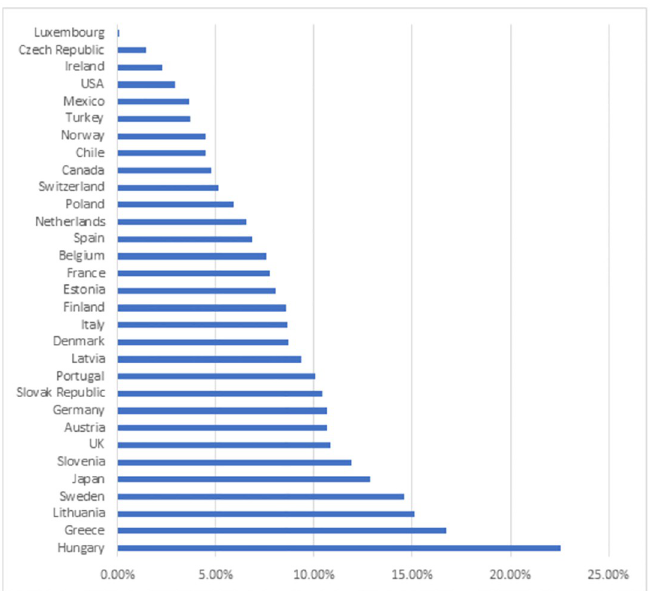
Fig 2. Rating of countries on the stability of financial development in 2020. Source: authors’ calculations based on the official statistical data [50]. index; and Hungary (22.56), Greece (16.74), Lithuania (15.11) had a maximum positive stabil-